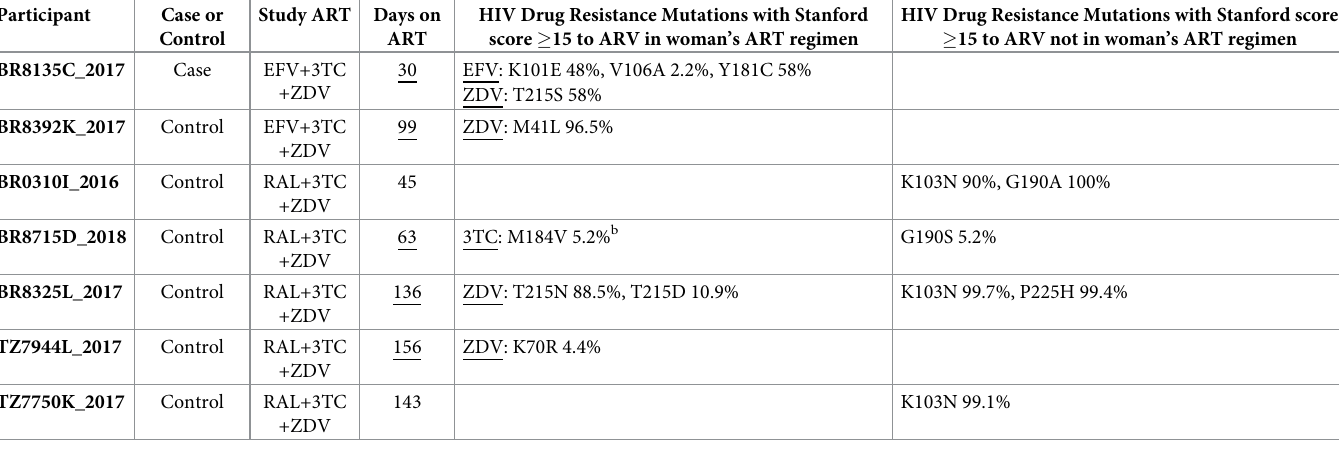
Table 2. Pre-ART HIV drug resistance mutations with stanford score � 15 detected by Illumina a sequencing and their frequencies in individuals’ HIV quasispecies.